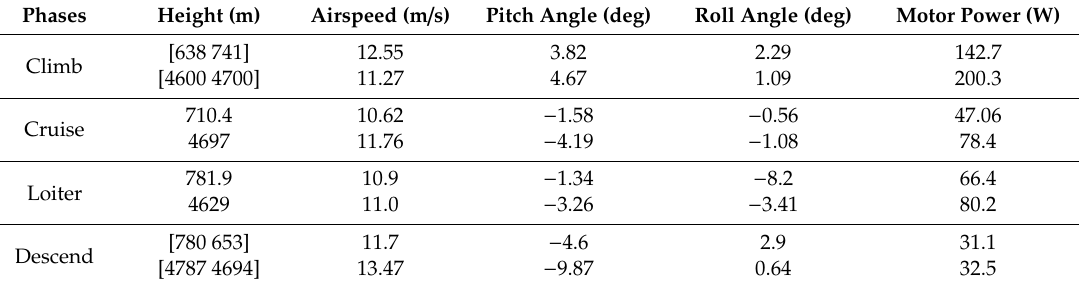
Table 10. Flight parameters for four typical phases at different altitudes.